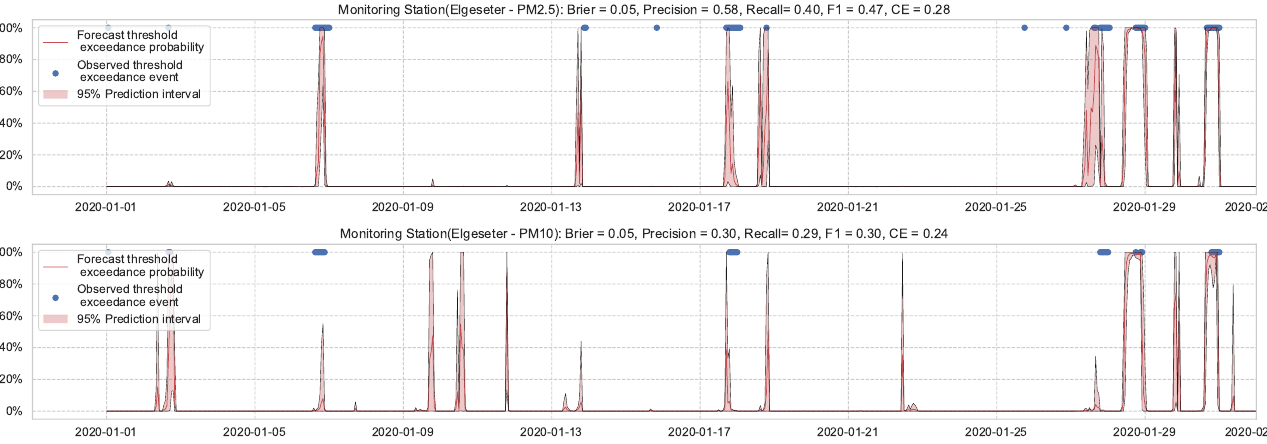
Figure 18. Predicting threshold exceedance probability of air pollutants level using an LSTM model with MC